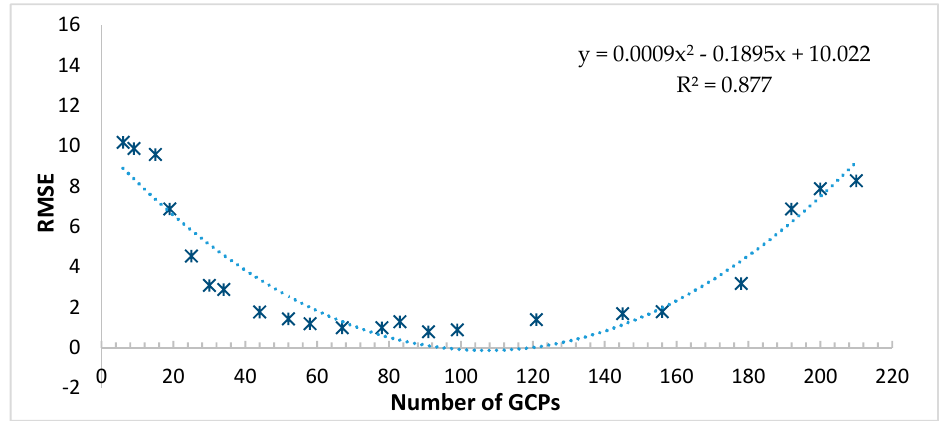
Figure 11. Exponential regression between number of GCPs and RMSE.